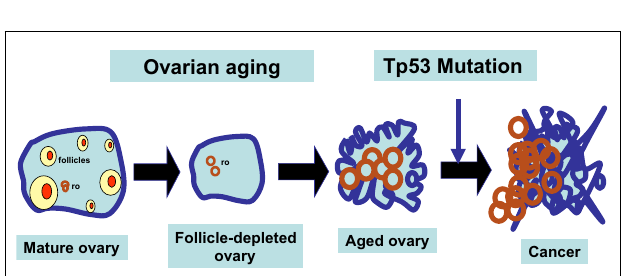
FIGURE 2 | Epithelial ovarian tumors inWv/Wv mice . Ovarian tissues were harvested and subjected to histological analysis. Cytokeratin-8 staining was used as a marker for epithelial cells. Representative ovaries are shown for 8-, 12-, 16-, and 35-week-oldWv/Wv mice, indicating the progressive increase in epithelial lesions. In comparison, a wild type ovary from a 16-week-old littermate has a single layer of cytokeratin-8-positive ovarian surface epithelium.The arrows in the two left panels indicate the putative lesions that developed from rete ovarii.